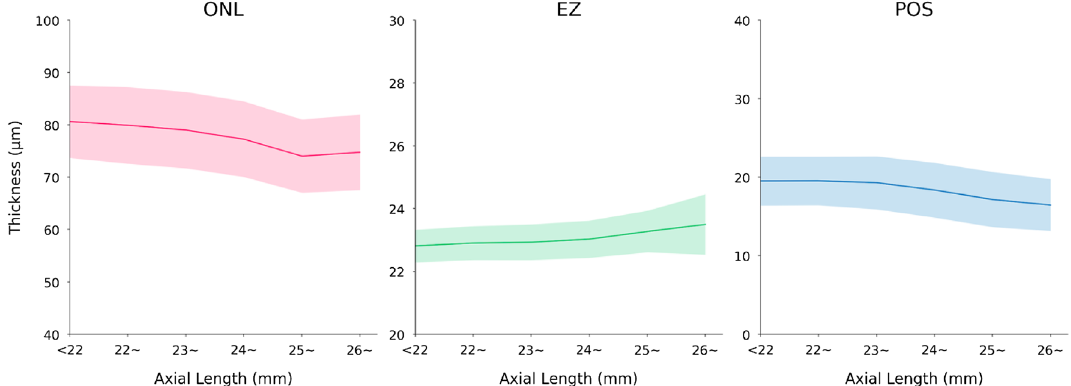
Figure 4. Graph showing the axial length-related change (mean value (line) and standard deviation (shadow)) in the thickness of the retinal outer nuclear layer (ONL), ellipsoid zone (EZ), and photoreceptor outer segment band (POS).